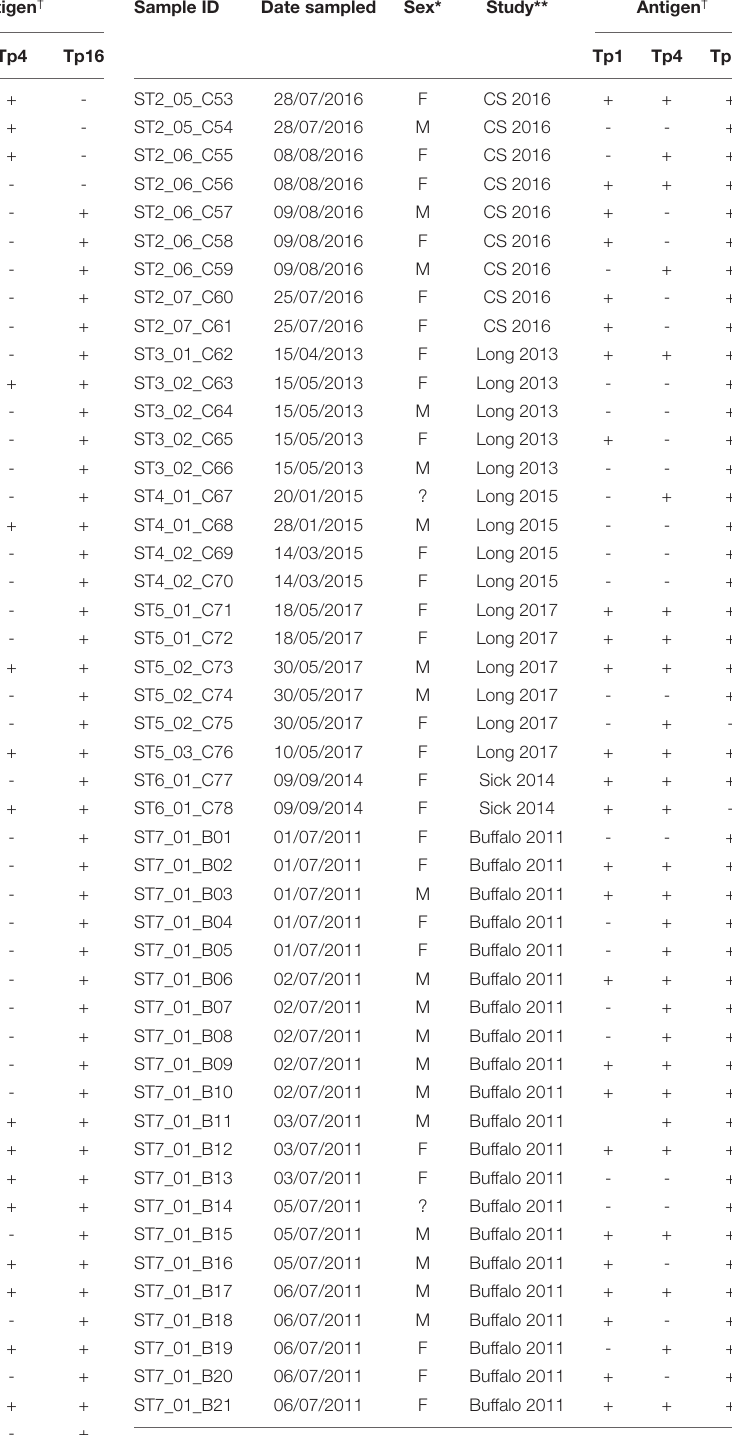
TABLE 3 | Summary of data per